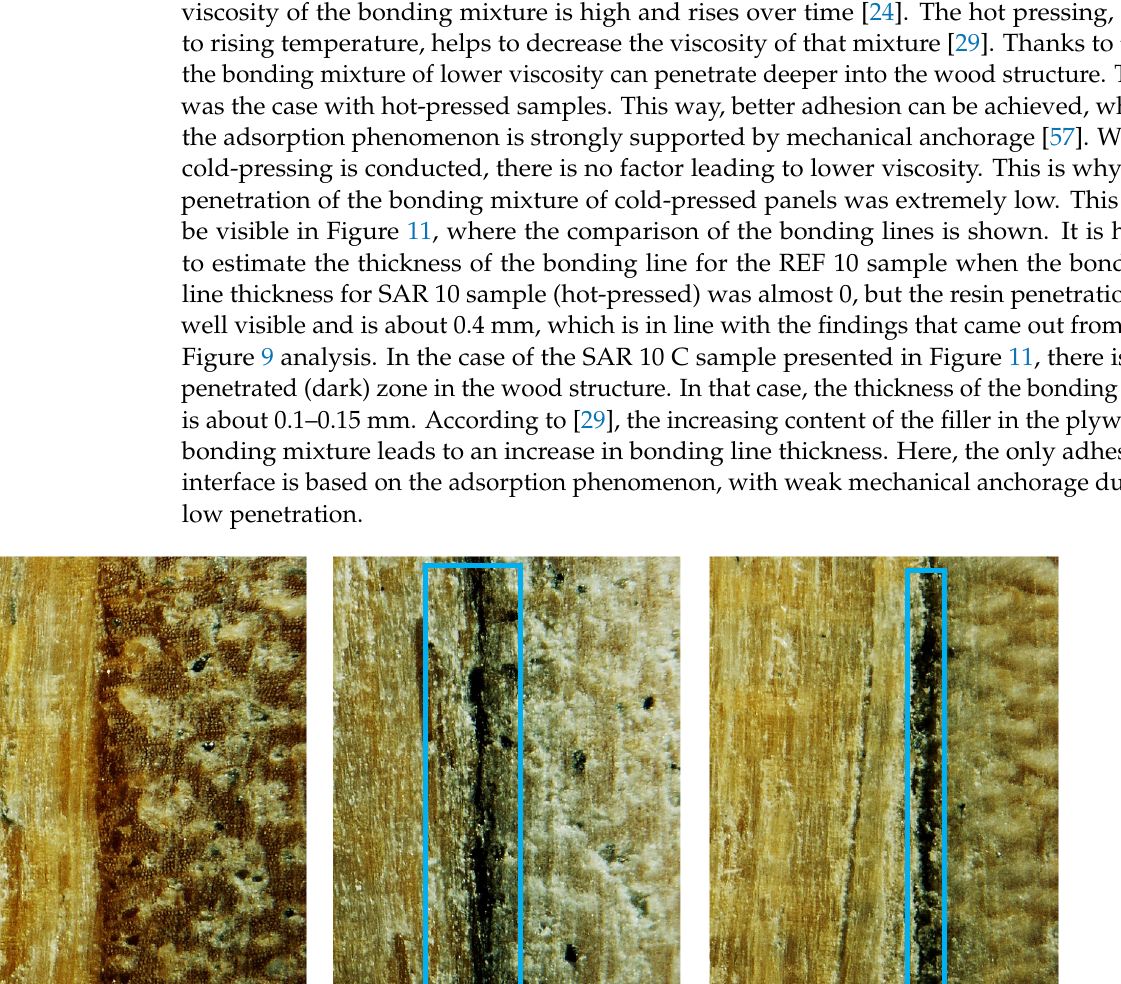
Figure 9. The density profiles of the plywood samples of different SAR filler content, hot-pressed.